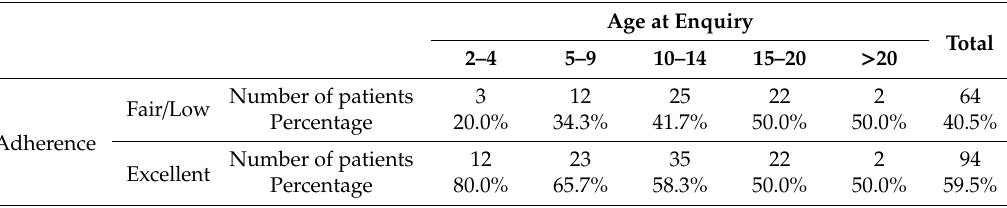
Table 4. Adherence to GFD tends to decrease with increasing age.